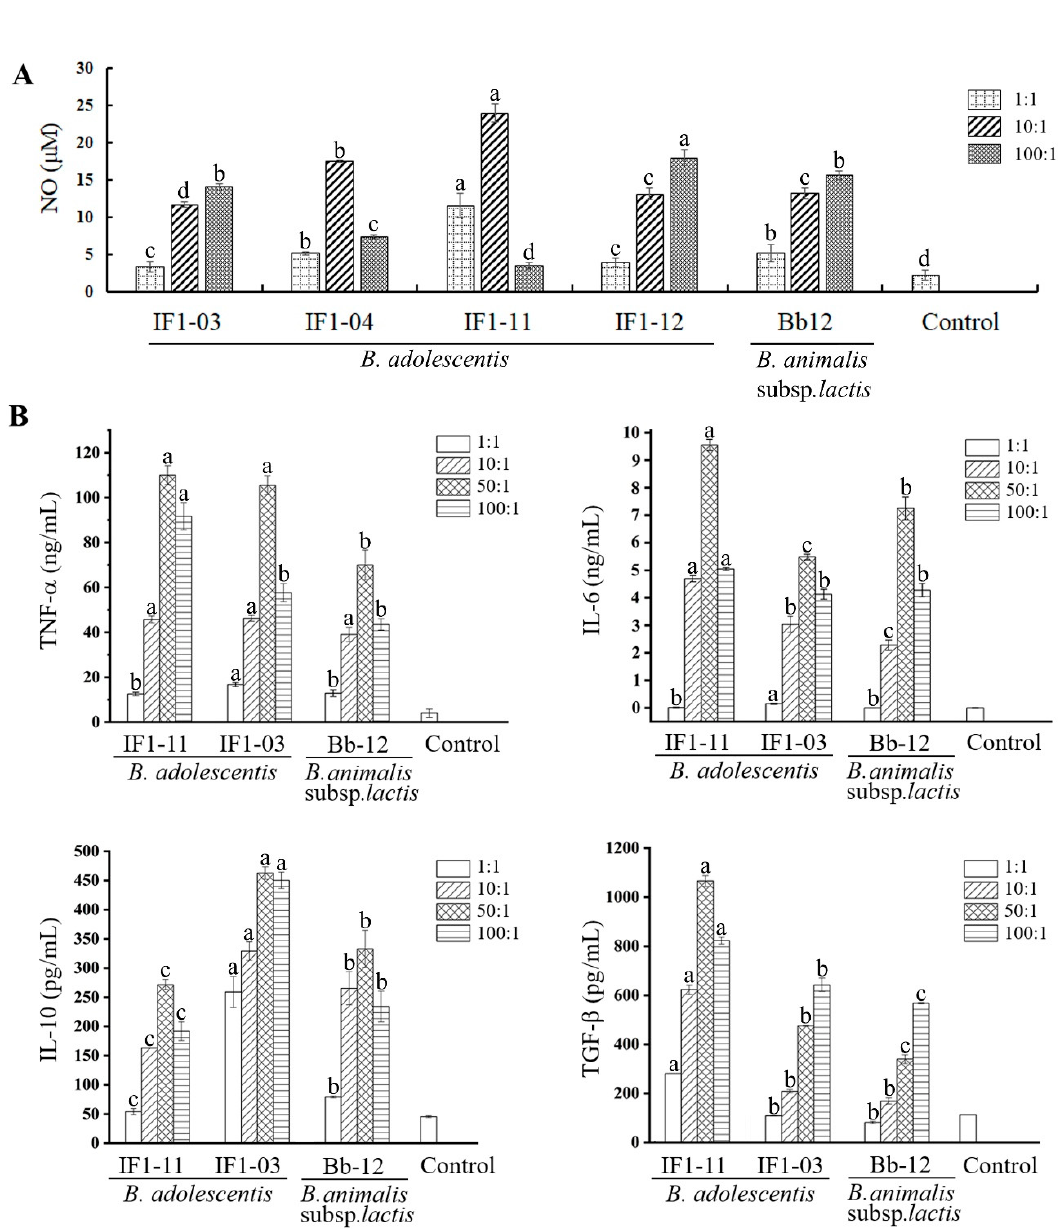
Figure 1. NO and cytokine secretion profiles of RAW264.7 macrophages stimulated by bifidobacterial strains. RAW264.7 macrophages were cocultured with B. adolescentis IF1-11, B. adolescentis IF1-03 or B. animalis subsp. lactis Bb12 for 24 h at the indicated ratios. The supernatant NO ( µ M) was analyzed by the Griess assay ( A ) and cytokines by ELISA ( B ). All strains were prepared at a density of 5 × 10 5 –10 7 cfu/mL in DMEM, and RAW264.7 macrophage cells were at 5 × 10 5 cell/mL. Ratios—1:1, 5 × 10 5 cfu:5 × 10 5 cell; 10:1, 5 × 10 6 cfu:5 × 10 5 cell; 50:1, 2.5 × 10 7 cfu:5 × 10 5 cell; 100:1, 5 × 10 7 cfu:5 × 10 5 cell, per reaction respectively. Data are shown as mean ± SD for three independent experiments, significant differences in each ratio group are labelled with different letters by one-way ANOVA, p < 0.05. TNF- α : Tumor Necrosis factor, IL-6: Interleukin 6, IL-10: Interleukin 10, TGF- β : Transforming growth factor β